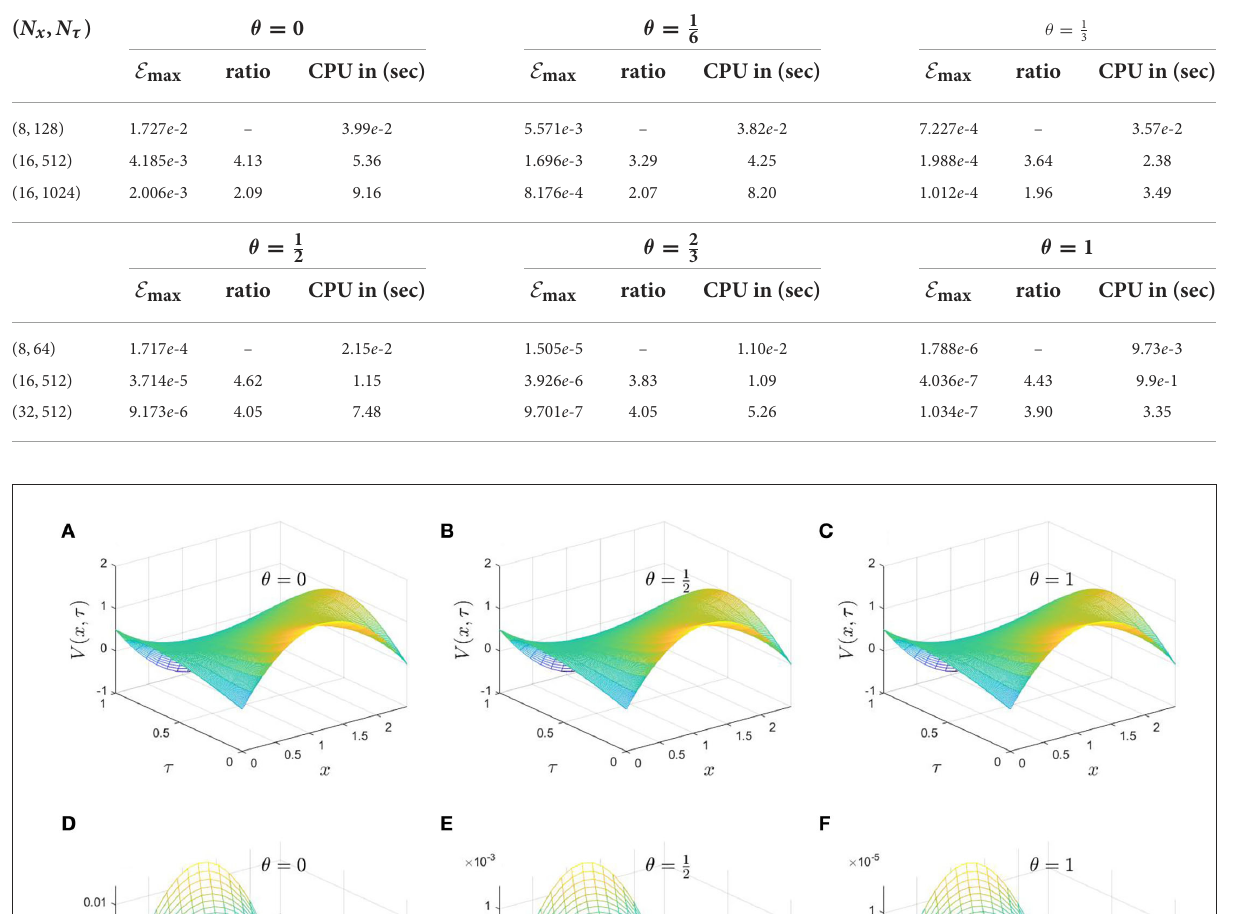
TABLE 5 The maximum absolute errors, their consecutive ratios, and CPU time for several values of θ of Example